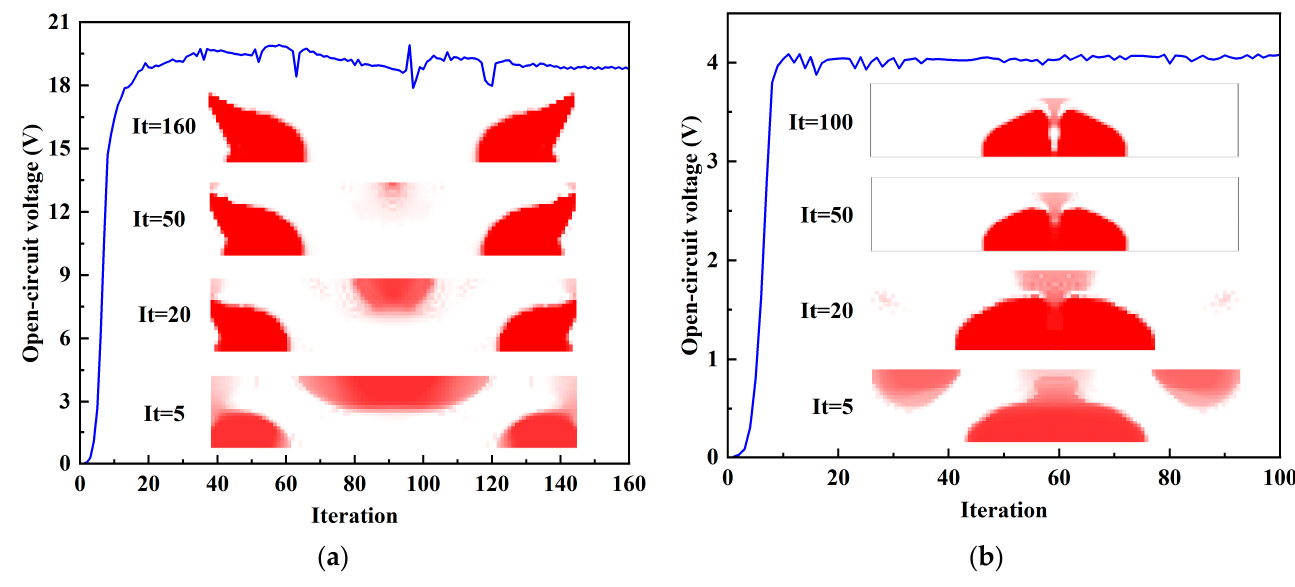
( d ) Figure 9. Voltage distribution of the open ‐ circuit voltage enhanced designs in Figure 8. ( a ) Voltage contour of Figure 8a, f = 4 kHz; ( b ) Voltage contour of Figure 8b, f = 6 kHz; ( c ) Voltage contour of Figure 8c, f = 10 kHz; ( d ) Voltage contour of Figure 8d, f = 16 kHz. Figure 10 shows the iterative history and the topological evolution of the open ‐ circuit voltage designs at 4 kHz and 16 kHz. The open ‐ circuit voltage tends to converge after 40 iterations in Figure 10a. It can also be seen that some fluctuations appear in the conver ‐